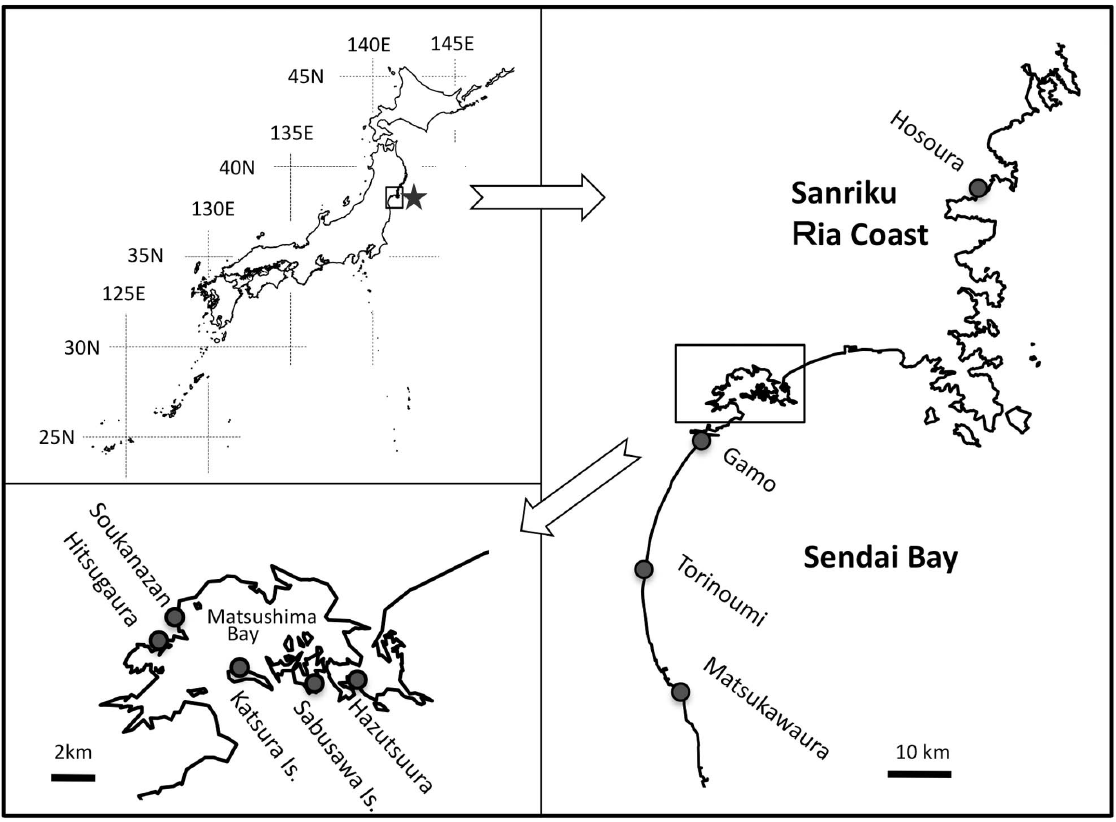
Figure 1. Maps of the Japanese Islands and the Pacific coastline of eastern Japan showing Sendai Bay and Matsushima Bay (an inner bay of Sendai Bay) with locations of the intertidal flats examined in this study (dark circles). Location of the seismic center of the Great East Japan Earthquake on 11 March 2011 is denoted by a star.